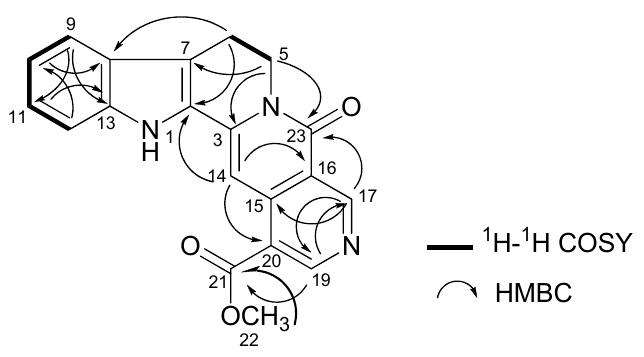
Figure 2. Selected 2D NMR correlations of neonaucline ( 1